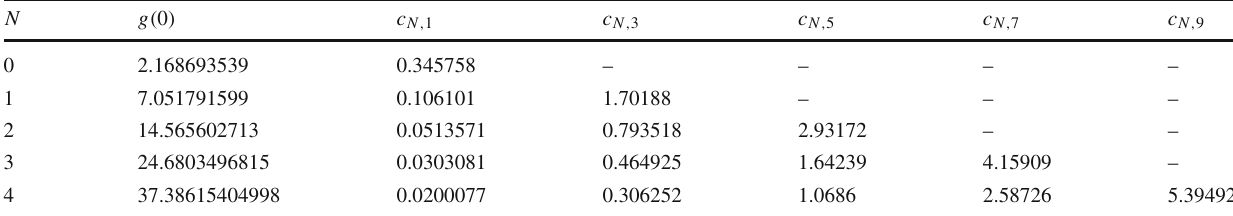
Table 1 Initial value g ( 0 ) for use in shooting-method solutions to Eq. (55) with ε = 0 as well as coefficient values for Eq. (56)